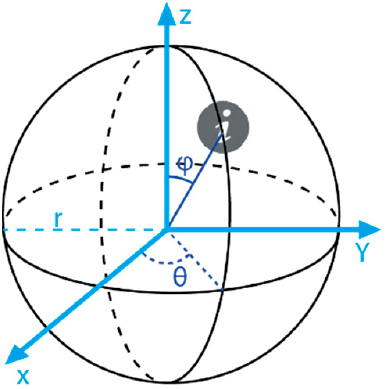
Figure 23. Positioning of the information in the panoramas.